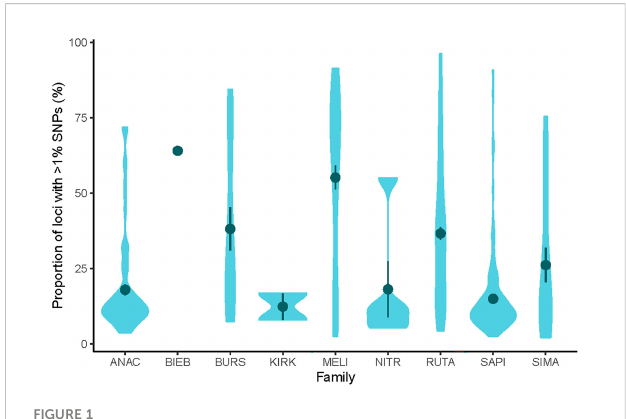
FIGURE 1 Violin plots of mean proportion of paralogous loci (loci with >1% SNPs) of each family in Sapindales as calculated with HybPhaser. ANAC, Anacardiaceae (n = 79), BIEB, Biebersteiniaceae (n = 1), BURS, Burseraceae (n = 16), KIRK, Kirkiaceae (n = 2), MELI, Meliaceae (n = 56), NITR, Nitrariaceae (n = 5), RUTA, Rutaceae (n = 136), SAPI, Sapindaceae (n = 134), SIMA, Simaroubaceae (n =